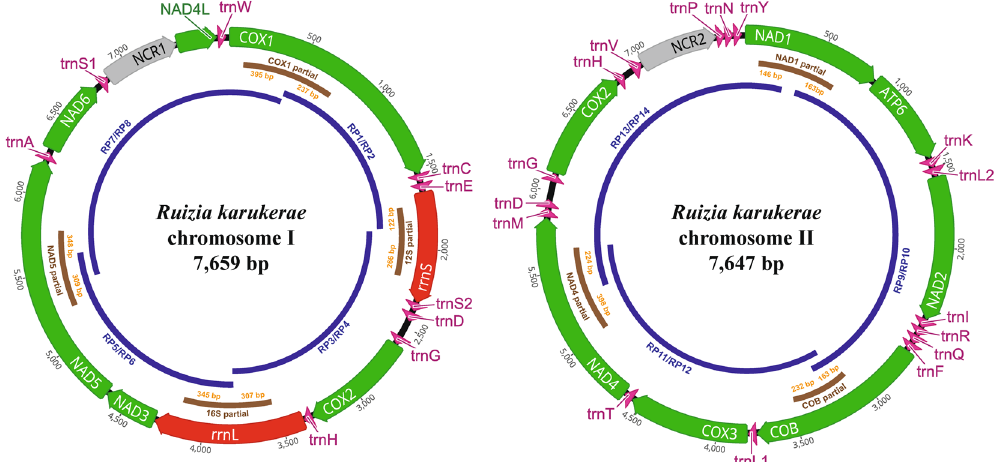
Figure 1. A representation of the two circular mitochondrial chromosomes of Ruizia karukerae . All genes are encoded in the same direction, and the 22 tRNA genes are indicated by a single-letter abbreviation. The leucine and serine tRNA genes are marked according to their anticodon sequence as L1 ( trnL1 -uag), L2 ( trnL2 -uaa), S1 ( trnS1 -ucu) and S2 ( trnS2 -uga). Primer names (see Table 2 for details) are in blue lettering, and blue curved bars indicate long PCR fragments. Brown curved bars indicate partial gene fragments obtained by 7 independent PCR reactions. Orange numbers indicate length of sequence overlap between the partial sequences and ends of long PCR